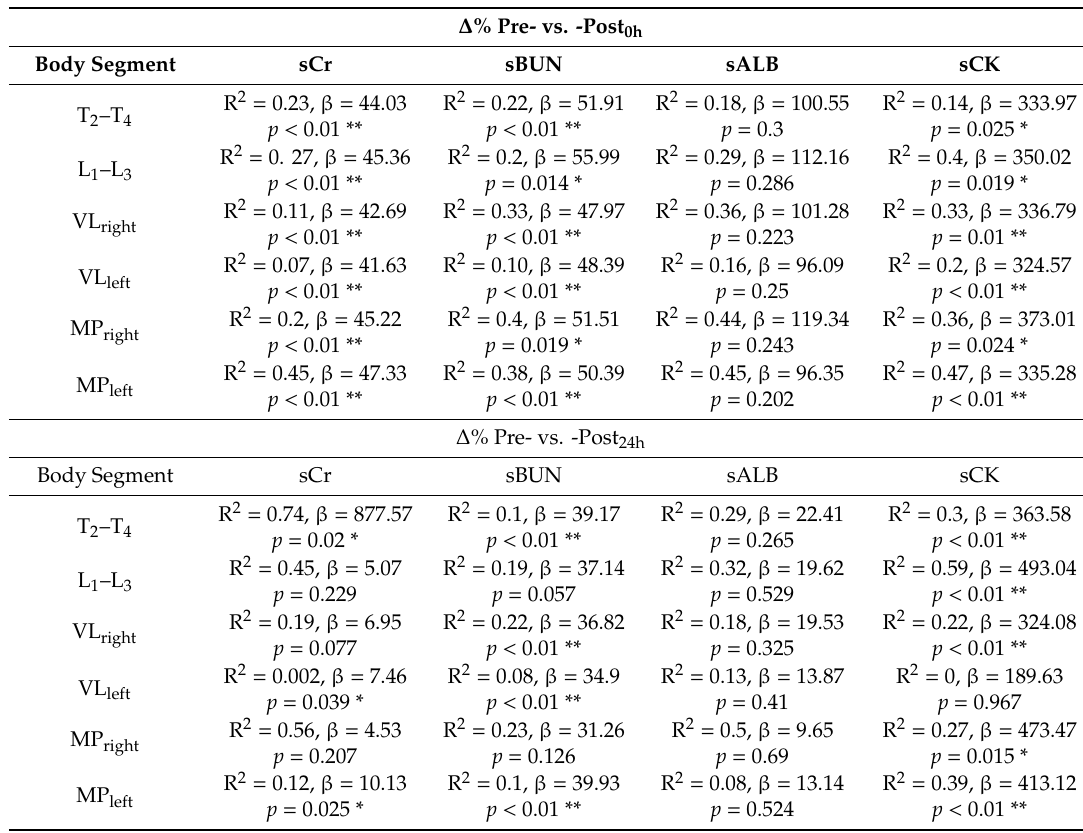
Table 3. Body segments external workload indicators (principal components) that predicted muscle and kidney injury serum